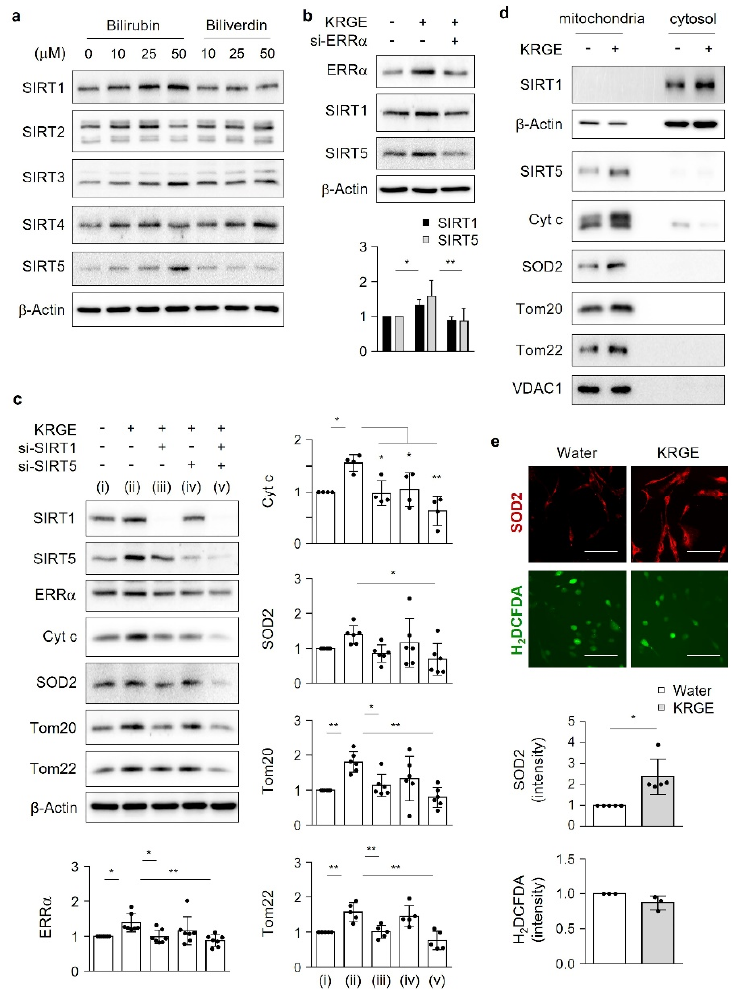
Figure 5. SIRT1 and SIRT5 synergistically regulate the KRGE-induced expression of the mitochondria outer membrane proteins Tom20 and Tom22. ( a ) Astrocytes were incubated with 50 µ M bilirubin or 50 µ M biliverdin for 4 h. Indicated protein levels were assessed by Western blotting ( n = 5–6). ( b , c ) Astrocytes were transfected with control or target siRNAs, followed by administration of 0.5 mg/mL KRGE for 24 h. ( b ) Indicated protein levels (i.e., SIRT1 ( n = 5) and SIRT5 ( n = 6)) were detected by Western blotting and quantified. ( c ) (i) Water + control siRNA; (ii) KRGE + control siRNA; (iii) KRGE + SIRT1 siRNA (si-SIRT1); (iv) KRGE + si-SIRT5; (v) KRGE + si-SIRT1 + si-SIRT5. Indicated protein levels were detected by Western blotting and quantified ( n = 4–6 independent experiments). ( d ) Indicated proteins were obtained from cellular fractions separated into cytosol and mitochondria and detected by Western blotting ( n = 7). ( e ) Astrocytes were treated with water or 0.5 mg/mL KRGE for 24 h. SOD2 expression was detected by immunocytochemistry ( n = 5). H 2 DCFDA fluorescence demonstrating cellular ROS was determined ( n = 3). Scale bar = 100 µm. * p < 0.05; ** p < 0.01. ROS, reactive oxygen species; SIRT, sirtuin; SOD2, superoxide dismutase 2; Tom, translocase of the outer mitochondrial membrane. 3.7. Exogenous Bilirubin Recovers KRGE-Modulated Mitochondrial Function in BVR-A- Depleted Astrocytes